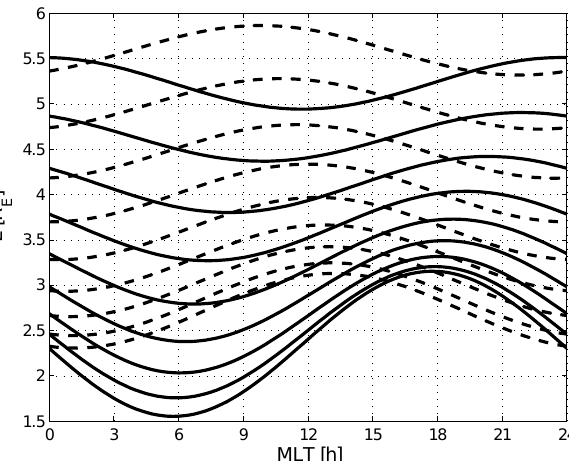
Fig. 12. Comparison of the diurnal variation of the MSFAC bound- ary (dashed) and the PPCH-2012 plasmapause position (solid) for Kp=0.5, 1.5, ...